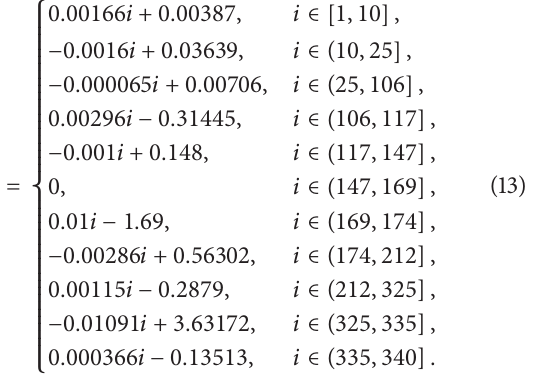
Figure 2: Classification of errors.